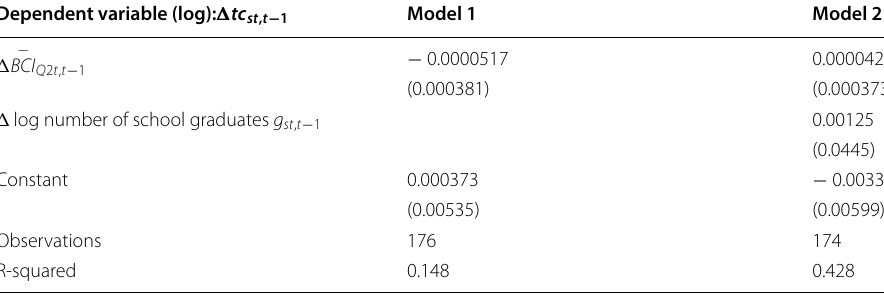
Heteroskedasticity and autocorrelation‑robust standard errors in parentheses. a Significant at the 1%‑level; b significant at the 5%‑level; c significant at the 10%‑level. Data sources: Vocational training statistics of the statistical offices of the federal and state governments, ifo Business Climate